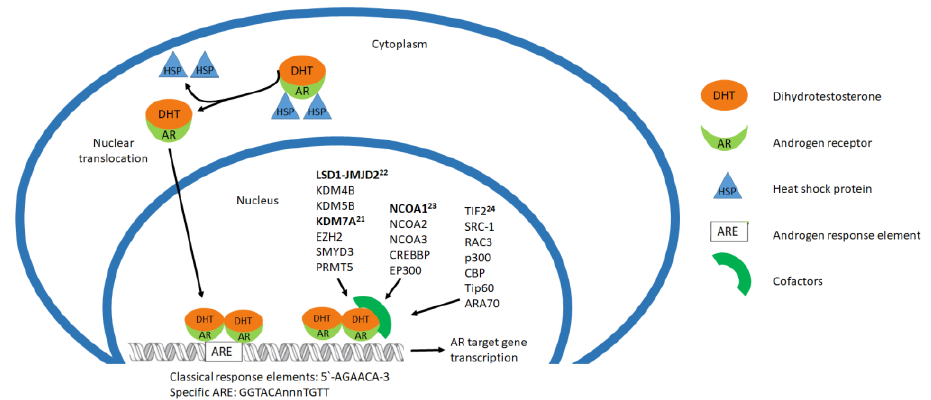
Figure 2. Cofactors involved in the regulation of AR target gene expression. The AR interacts with enzymes (cofactors) involved in the regulation of histone methylation, such as lysine-specific demethylase 1 (LSD1), KDM4B, KDM5B, KDM7A, EZH2, SMYD3 and PRMT5. Lee et al., 2020 found that the interaction of AR and KDM7A suggested that this histone demethylase mediated the growth of bladder cancer